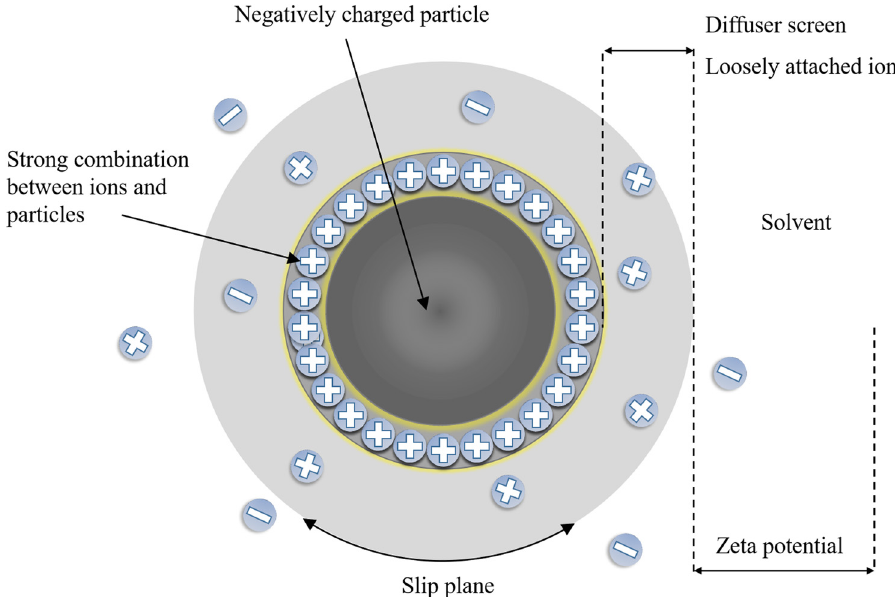
Figure 1: Schematic of zeta